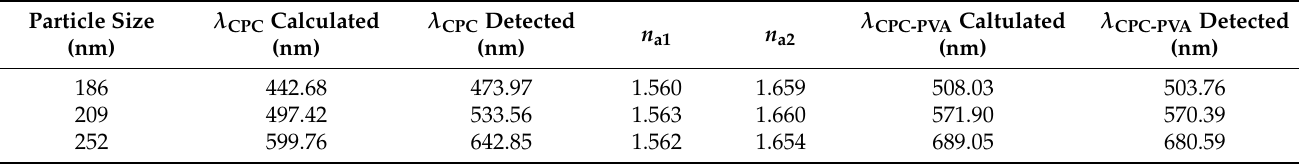
Table 1. Measured and theoretical values of diffraction peaks of CPCs.